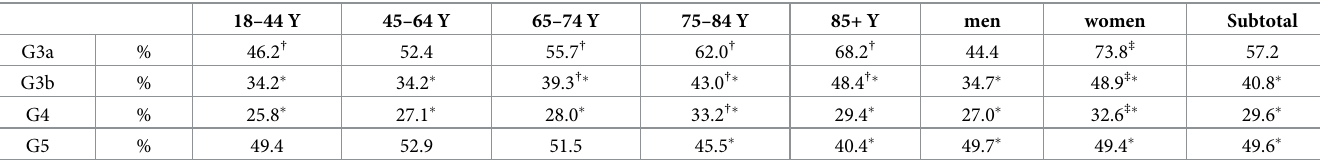
Table 5. Rates of UA level within optimal range (UA � 6.0 mg/dl) according to G category, age, and sex strata.